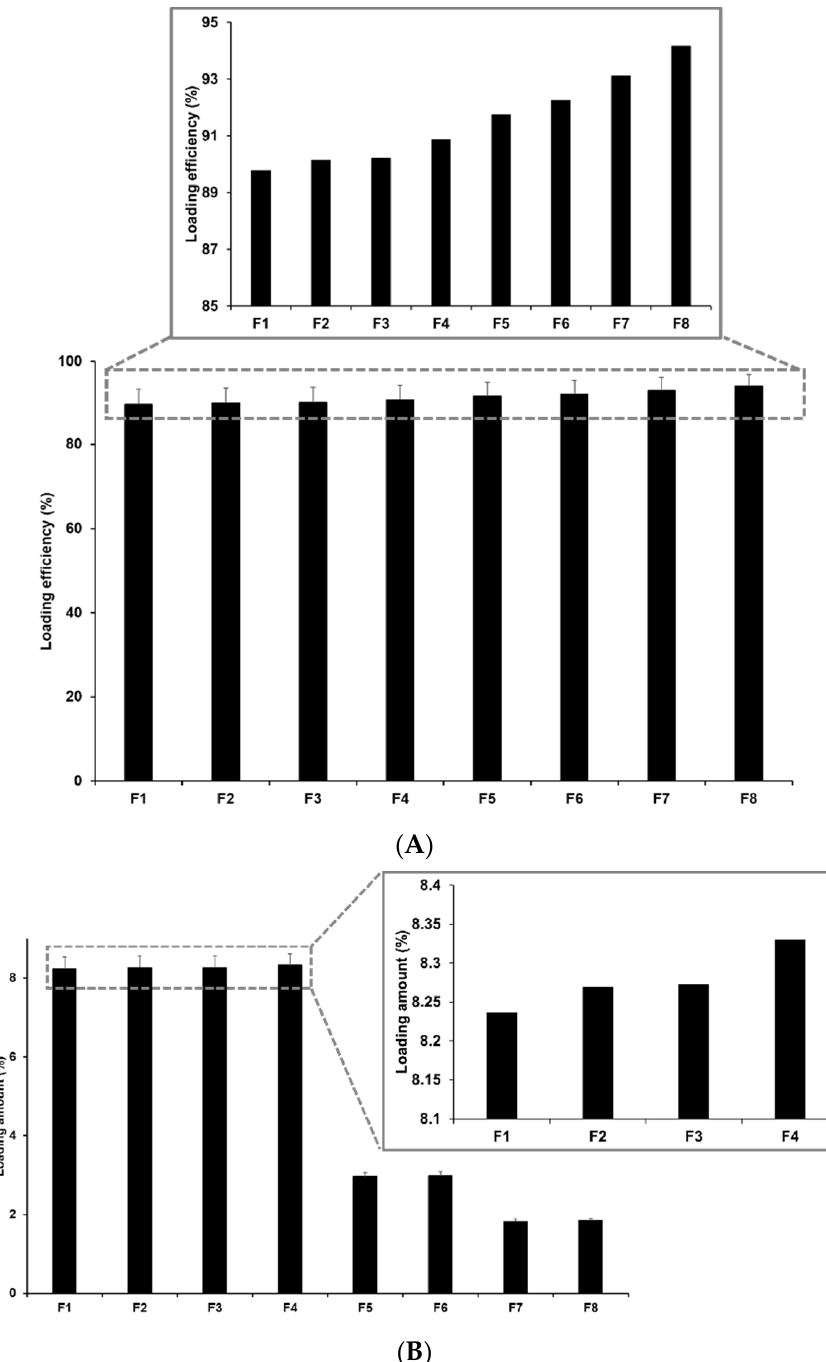
Figure 4. ( A ) Loading efficiency and ( B ) loading amount of P18-loaded SLNs prepared using different compositions. Results are expressed as the means ± standard deviations of three independent experiments ( n = 3).